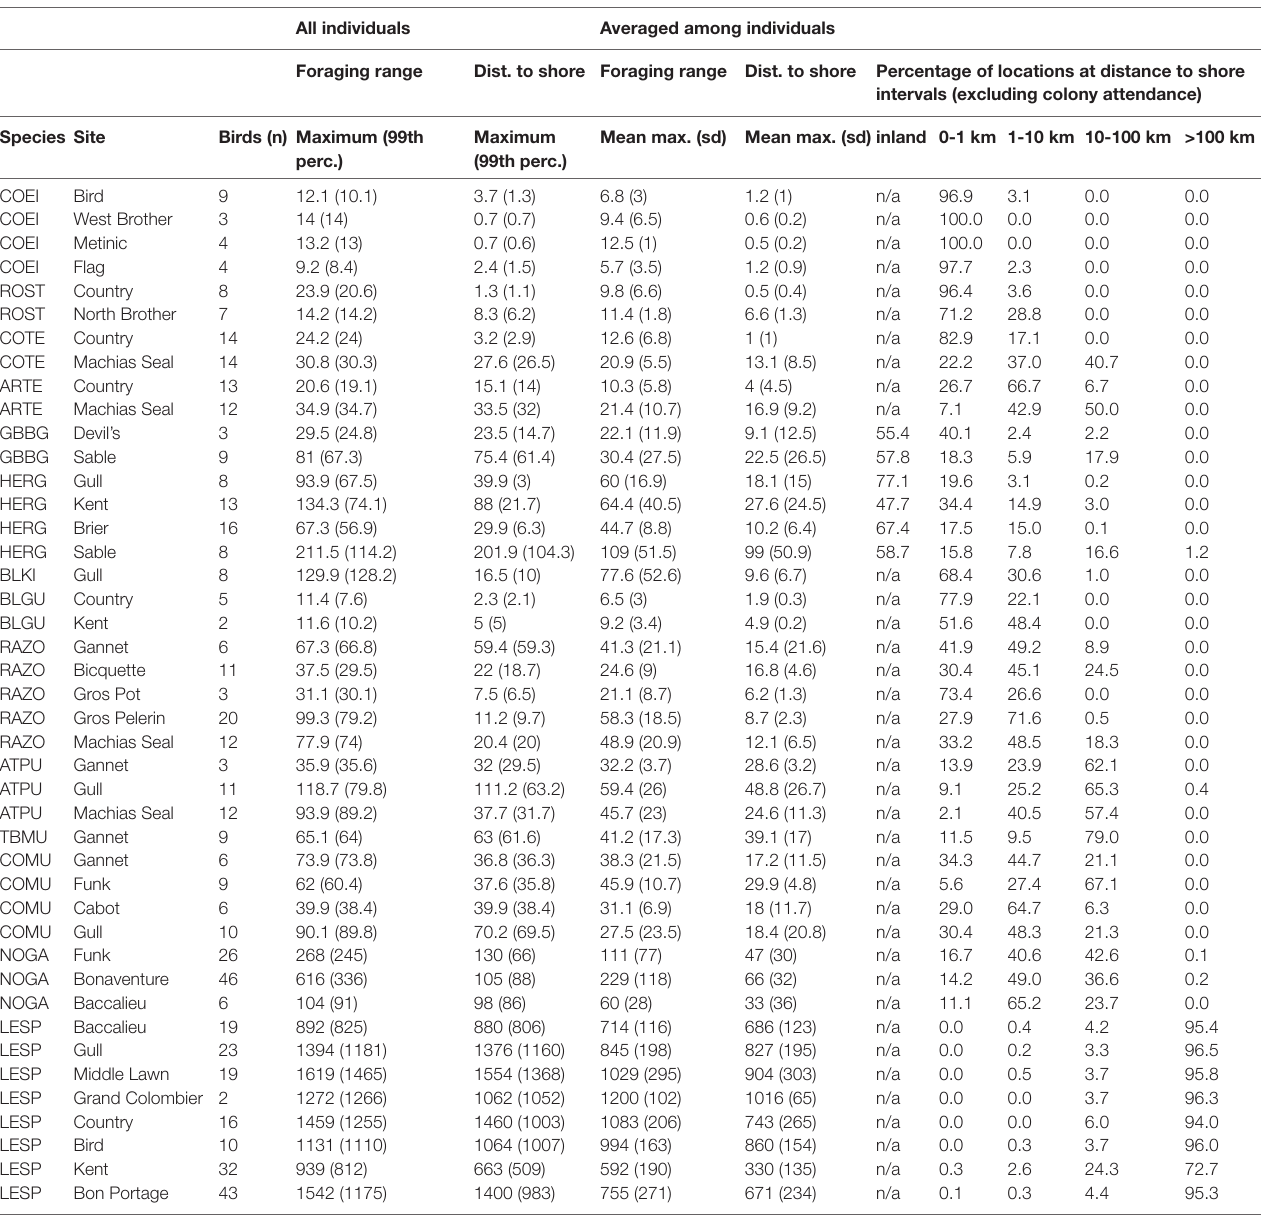
intervals (excluding colony attendance)